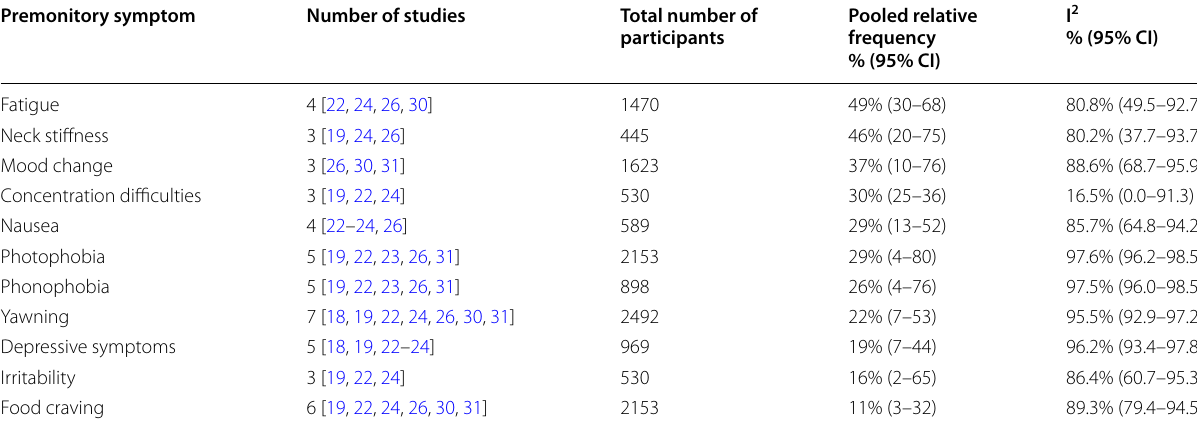
Table 4 Relative frequency of individual premonitory symptoms in clinic-based